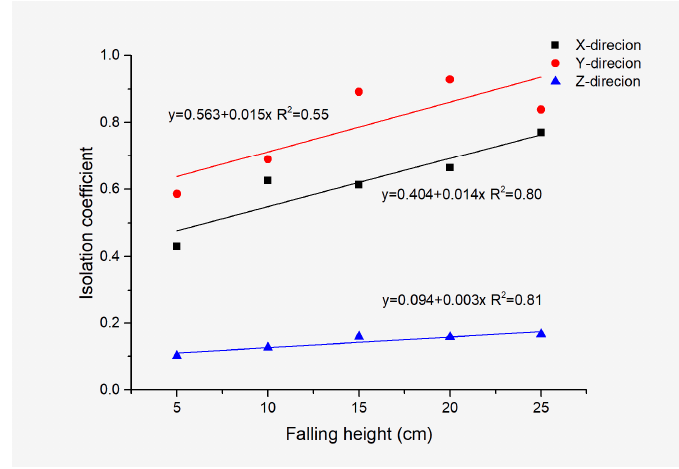
Figure 8. The isolation coefficient of the composite subgrade structure under different falling heights.